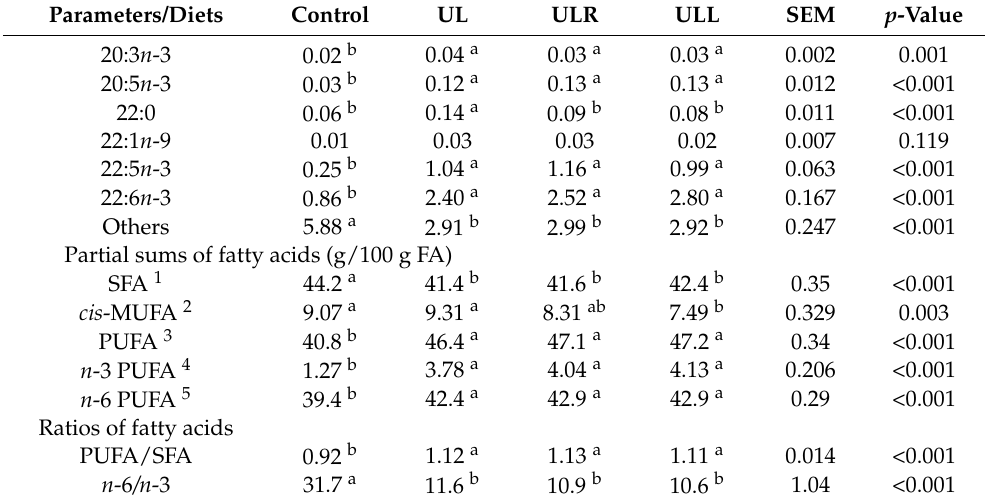
Table 3. Cont. Parameters/Diets Control